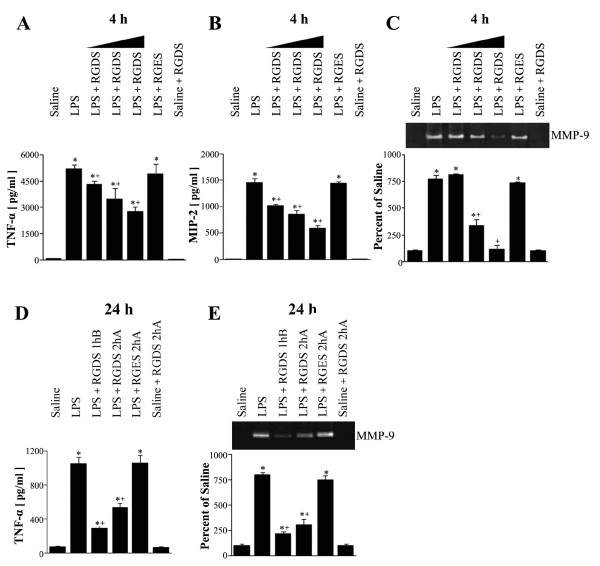
Effects of RGDS on LPS-induced TNF-α and MIP-2 productions, and on MMP-9 activity. Where indicated, mice were administered i.p. RGDS (1, 2.5 or 5 mg/kg) or RGES (5 mg/kg) once 1 h before LPS treatment and sacrificed 4 h post-LPS. Mice were also administered these peptides (5 mg/kg, i.p.) once 1 h before or 2 h after LPS and were sacrificed 24 h post-LPS (B). TNF-α and MIP-2 levels in BAL fluid samples were quantified using enzyme-linked immunosorbent assays (A, B, D). Gelatinolytic activity in BAL fluid samples (C, E). Samples were analyzed by zymography followed by scanning densitometry. The 92-kD genolytic bands corresponded to MMP-9. Densities are expressed as percentages versus saline treated controls. Values represent means ± SEM of results from 5 mice per group. *Significantly different from saline treated controls, p < 0.05; +significantly different from animals treated with LPS only, p < 0.05.